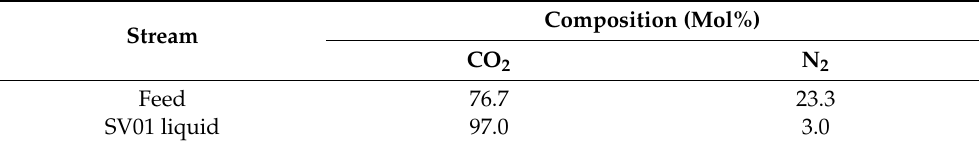
Table 5. Gas chromatograph measurements at the start of Experiment 4.